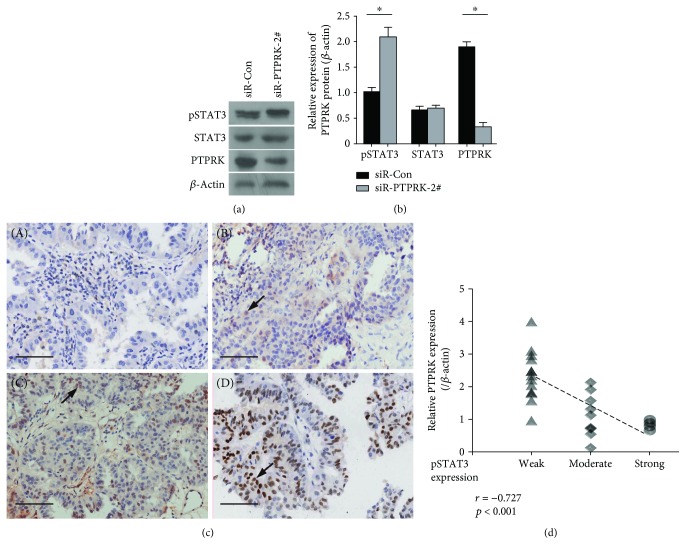
PTPRK downregulation contributes to STAT3 activation and is associated with poor prognosis of NSCLC. (a) The protein expression level of phopho-STAT3Tyr705, STAT3, and PTPRK was measured by western blotting in H1299 cells transfected with NC and PTPRK siRNA#2. (b) Densitometric quantifications of phopho-STAT3Tyr705, STAT3, and PTPRK protein levels in H1299 cells transfected with NC and PTPRK siRNA#2 according to (a). (c) Representative micrographs of immunohistochemical staining of the phopho-STAT3Tyr705 protein (brown nuclear staining) in 26 NSCLC tissues. (A) negative control; (B) weak positive (+) expression, weak staining pattern; (C) positive expression (++), medium staining pattern; (D) strong positive expression (+++), strong staining pattern. (d) Correlation between phopho-STAT3Tyr705 and PTPRK expression was analyzed. Expression of PTPRK in 26 clinical tissue samples was measured by real-time PCR.